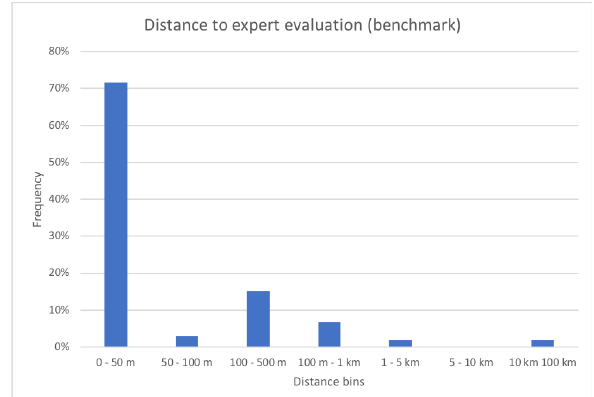
Figure 7. Crowd Vs Expert